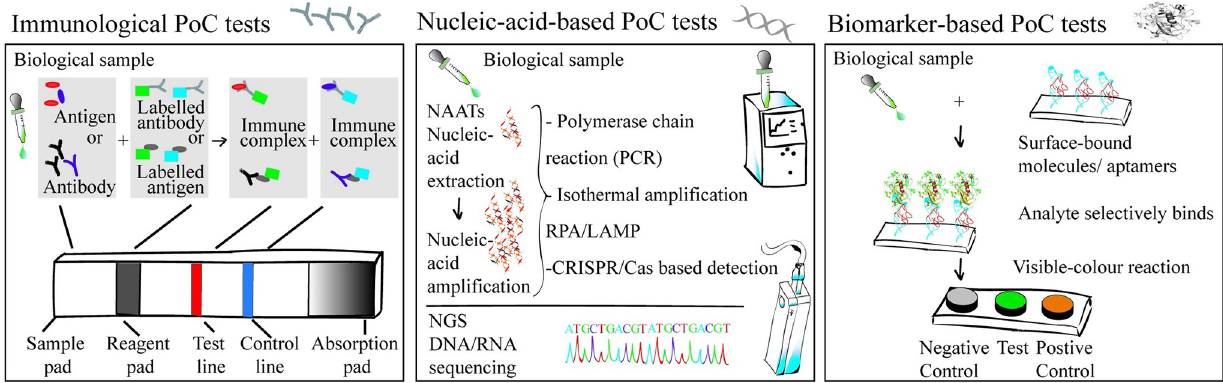
Fig 2. Three types of PoC diagnostic tests. A biological sample (such as blood, urine, saliva, sweat, etc.) can be utilized for various types of PoC diagnosis. Left : immunological PoC test. A biological sample is dropped unto the sample pad of a lateral flow assay, which acts as a filtering unit to sieve out unnecessary constituents. Upon administration of a reaction buffer (or its automated release), the analyte flows through the reagent pad, wherein an antigen–antibody complex is formed. Driven by capillary action, this complex migrates to the next zone with control and test lines. While the appearance of a visible color at the test line confirms the infection, the control line signal ensures the test functionality. Middle : nucleic acid–based PoC test. Here, genetic material of a pathogen serves as the analyte. DNA/RNA from the pathogen is extracted from infected host cells or circulating cell free within the clinical sample (body fluids). While extracted RNA is first reverse transcribed to obtain cDNA, extracted DNA can be directly amplified using PCR or using isothermal amplification (e.g., RPA or LAMP), typically in a fully automated portable unit. In some systems, the amplified DNA is then used for CRISPR/ Cas recognition or other downstream processing to yield a diagnostic result within a lateral flow assay or a microfluidic lab-on-a-chip device. NGS can also be utilized to identify specific diseases using a portable sequencer. Right : biomarker-based PoC test (other than antigen biomarkers). A biological sample is administered onto the test pad that in this case has specific surface-bound molecules such as aptamers that target the analyte. Upon successful interactions, a visible color readout is obtained. The test can be in the form of separate wells. LAMP, loop-mediated isothermal amplification; NGS, next-generation sequencing; PCR, polymerase chain reaction; PoC, point-of-care; RPA, recombinase polymerase amplification.